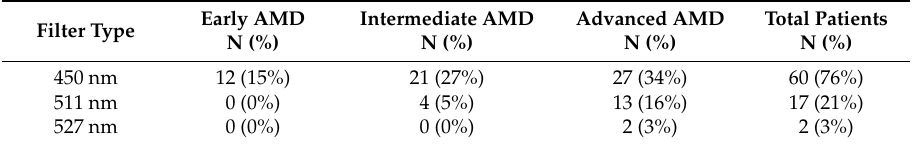
Table 1. Chosen filters by patients according to the state of their age-related macular degeneration (AMD). Filter